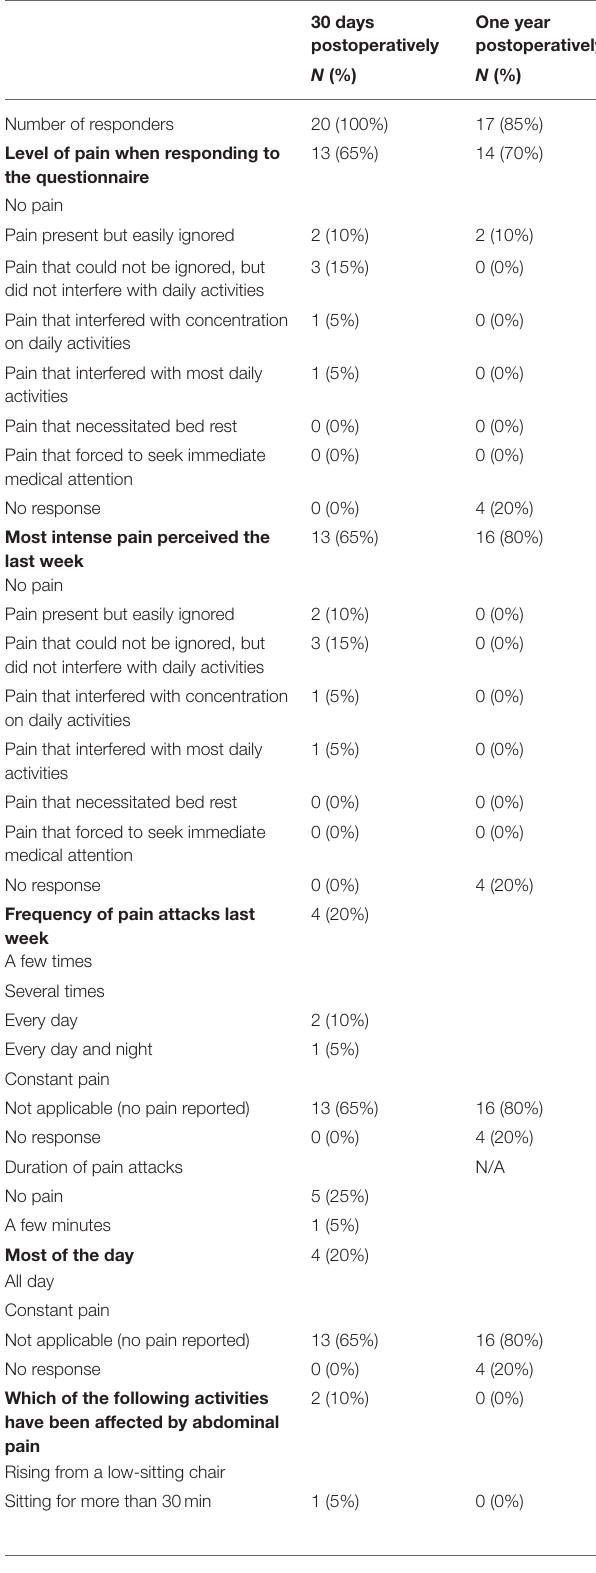
TABLE 2 | Ventral hernia pain questionnaire 30 days and 1 year